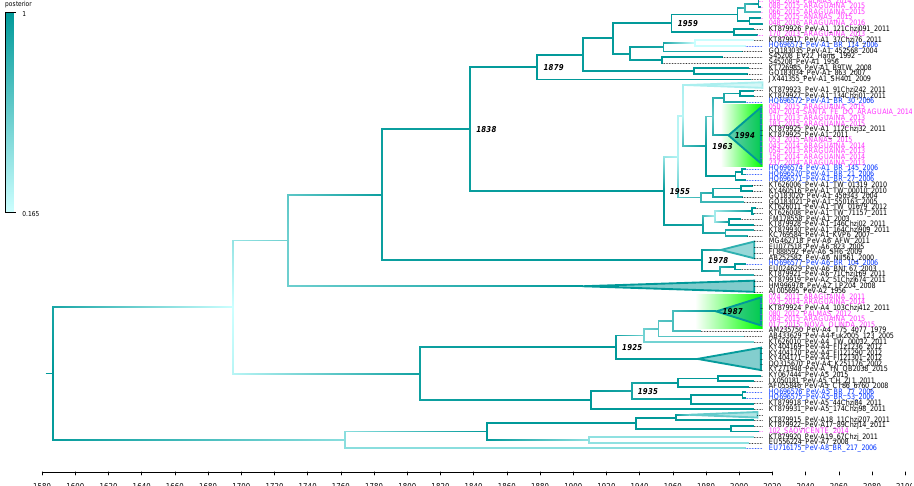
Figure 4. Maximum clade credibility tree based on the Vp1 gene of PeV-A. The Bayesian time-scaled tree maximum clade credibility tree was inferred using the relaxed molecular clock and the constant population size model. The x-axis represents chronological time, expressed in years. Sequences generated in the current study are indicated in magenta and Brazilian strains from a previous study are indicated in blue. Clades containing recombinant strains described in this study are indicated by green areas in the tree. The tree also shows (numbers at nodes) the divergence times of lineages, expressed in mean posterior estimate, of ages calibrated in years from the tMRCA. The branch color indicates the posterior probability as indicated by the scale in the left region of the figure. The main genotypes are indicated above the branches. PeV-A3 strains were collapsed in the tree. The tree was summarized using TreeAnnotator software. All these analyses were performed with the BMCMC approaches implemented in the BEAST package, version 1.10.4